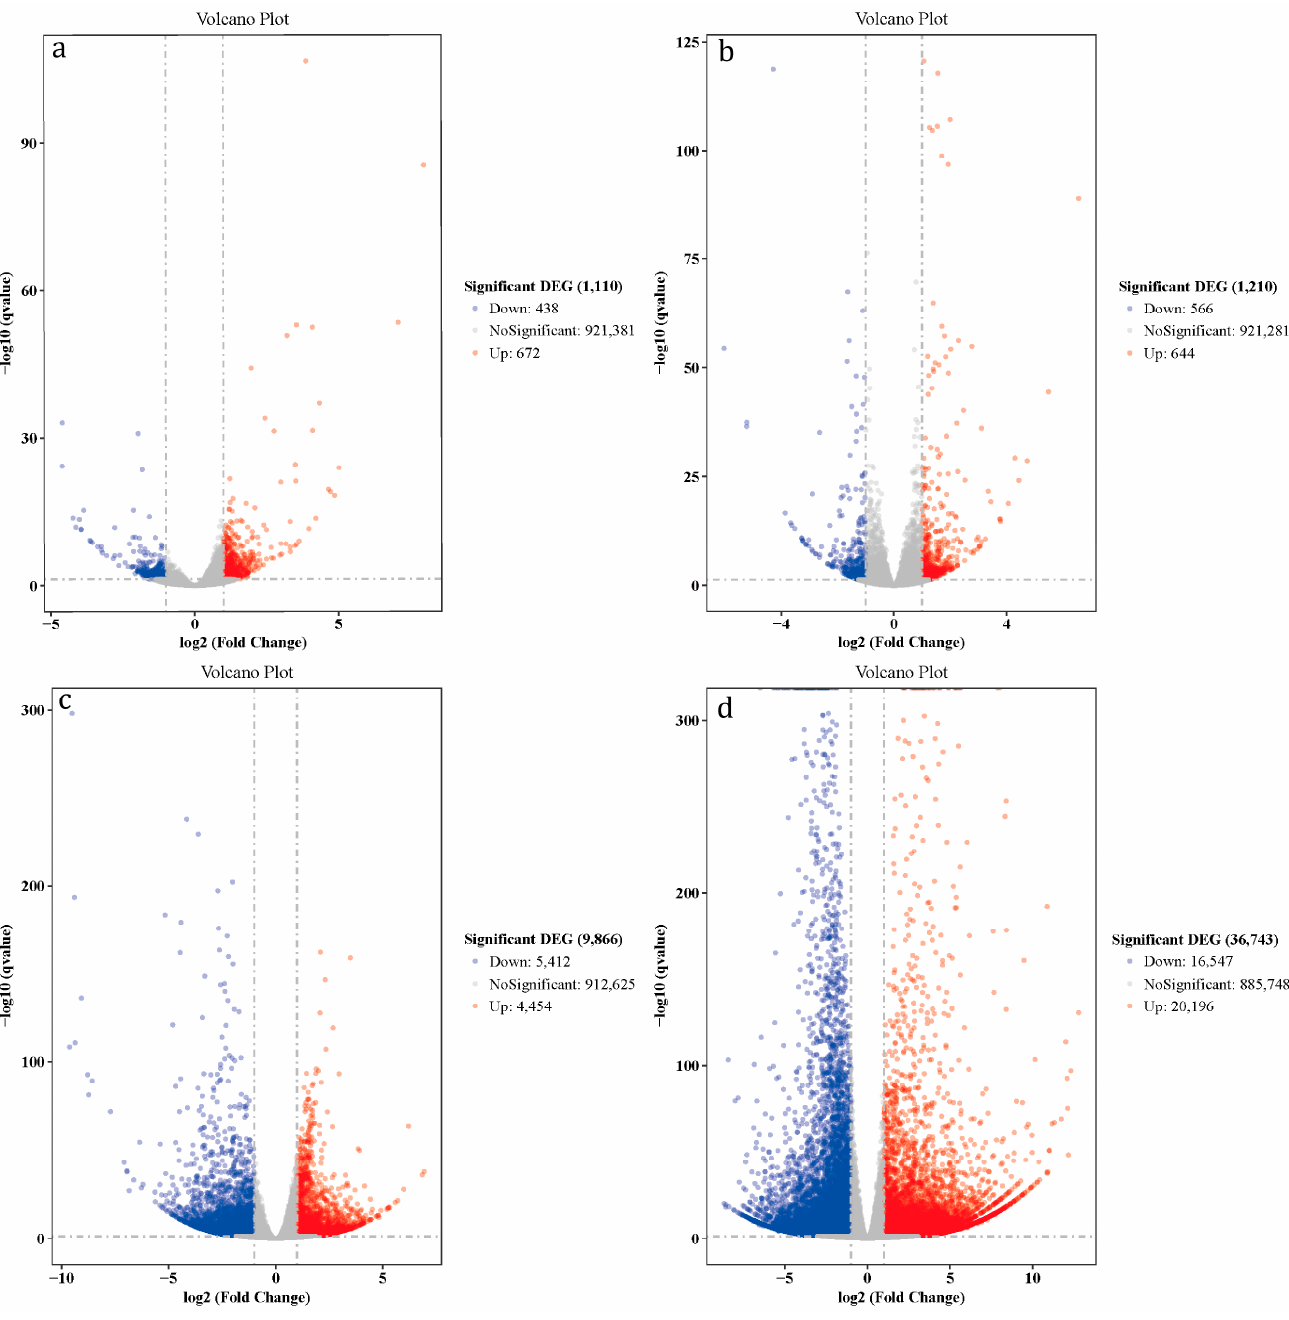
Figure 4. Volcano plots of DEGs. Horizontal is log 2 (Fold Change) and ordinate is − log10 ( q value). Red means up-regulation genes, blue means down-regulation genes and grey means no signi fi cant